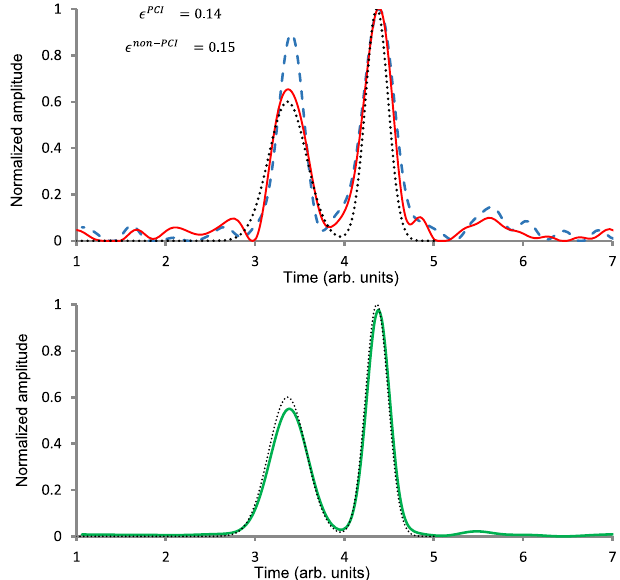
FIG. 5. As in Fig. 2 but with A 1 ¼ 1 ; A 2 ¼ 0 . 6 ; σ 1 ¼ 0 . 13 ; σ ¼ 0 . 21 ; t ¼ 0 . 64 ; t ¼ 1 . 64 ). The reconstructions are based 2 1 2 on: (a) a non-PCI (dashed blue line) and the PCI (solid red line) algorithms; (b) minimal phase reconstruction (solid green line). The black dotted line shows the original